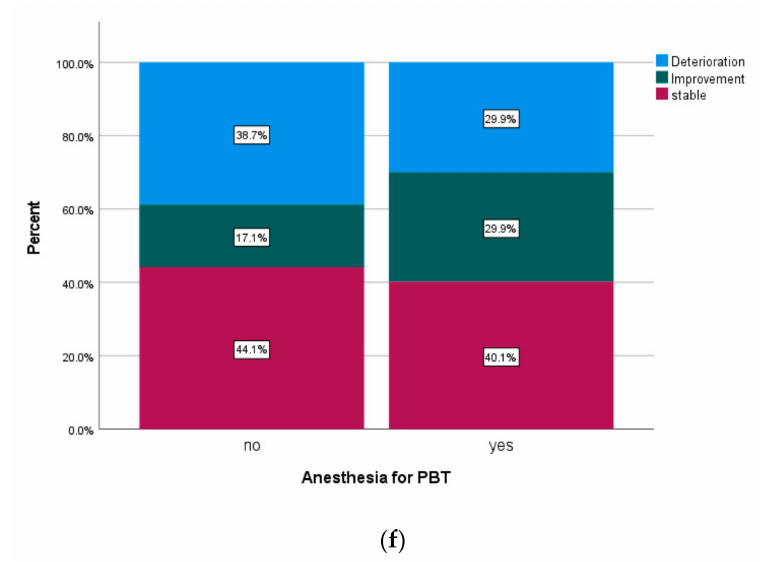
Figure 7. ( a – f ) Changes in maximum adverse events of the CNS according to CTCAE Version 4.0 three years after PBT divided by subgroups ( a ) age; ( b ) gender; ( c ) dose; ( d ) CSI; ( e ) extension of surgery; ( f ) anesthesia.